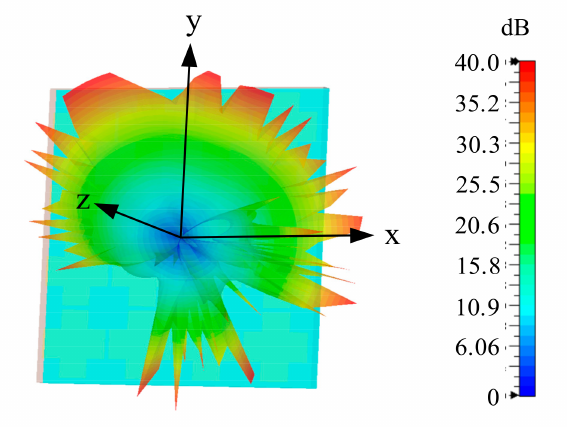
Figure 14. AR pattern at 5.5 GHz.